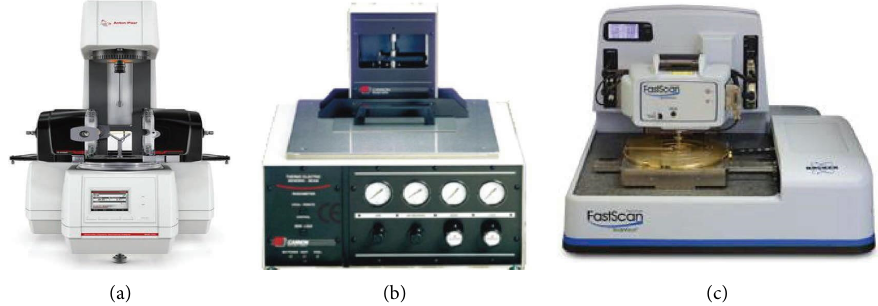
Figure 2: Testing equipment. (a) Anton Paar MCR 302. (b) TE-BBR. (c) Dimension